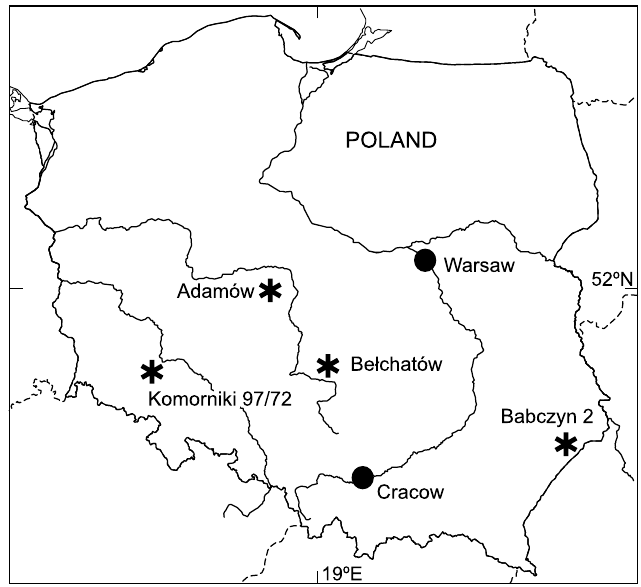
Fig. 1. Location of the investigated Miocene localities in Poland (aster - sisks) where ascospores of Potamomyces were